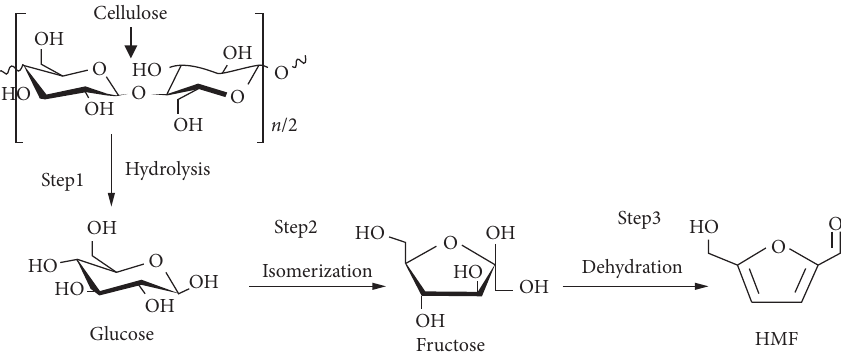
Scheme 1: Reaction mechanism for converting cellulose into